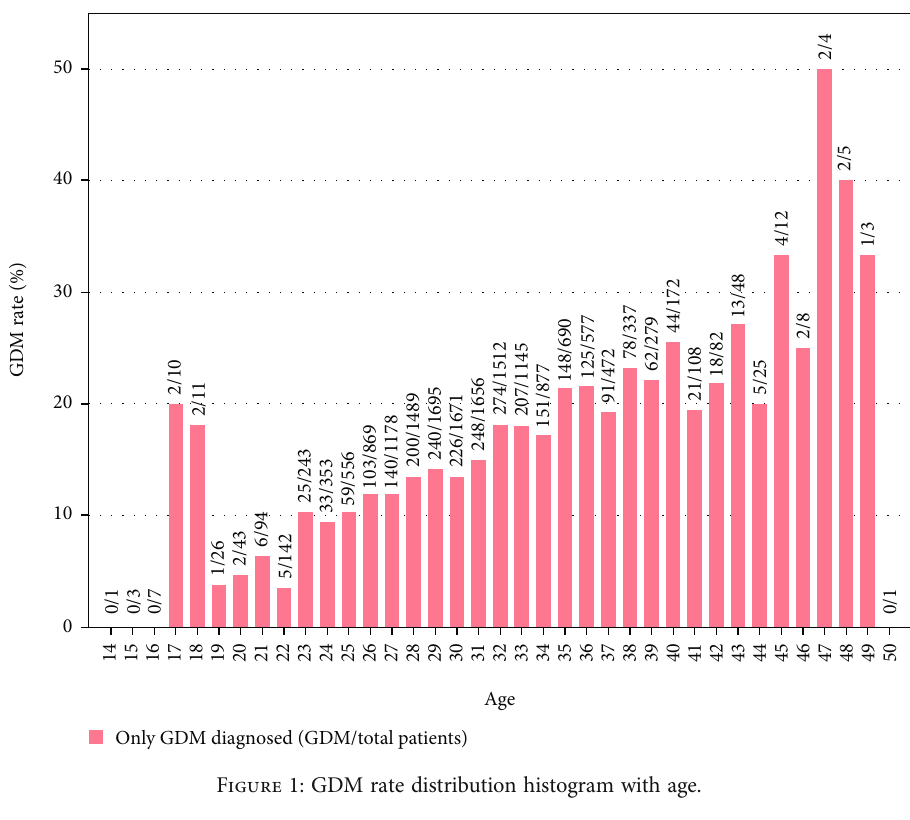
Figure 1: GDM rate distribution histogram with age.